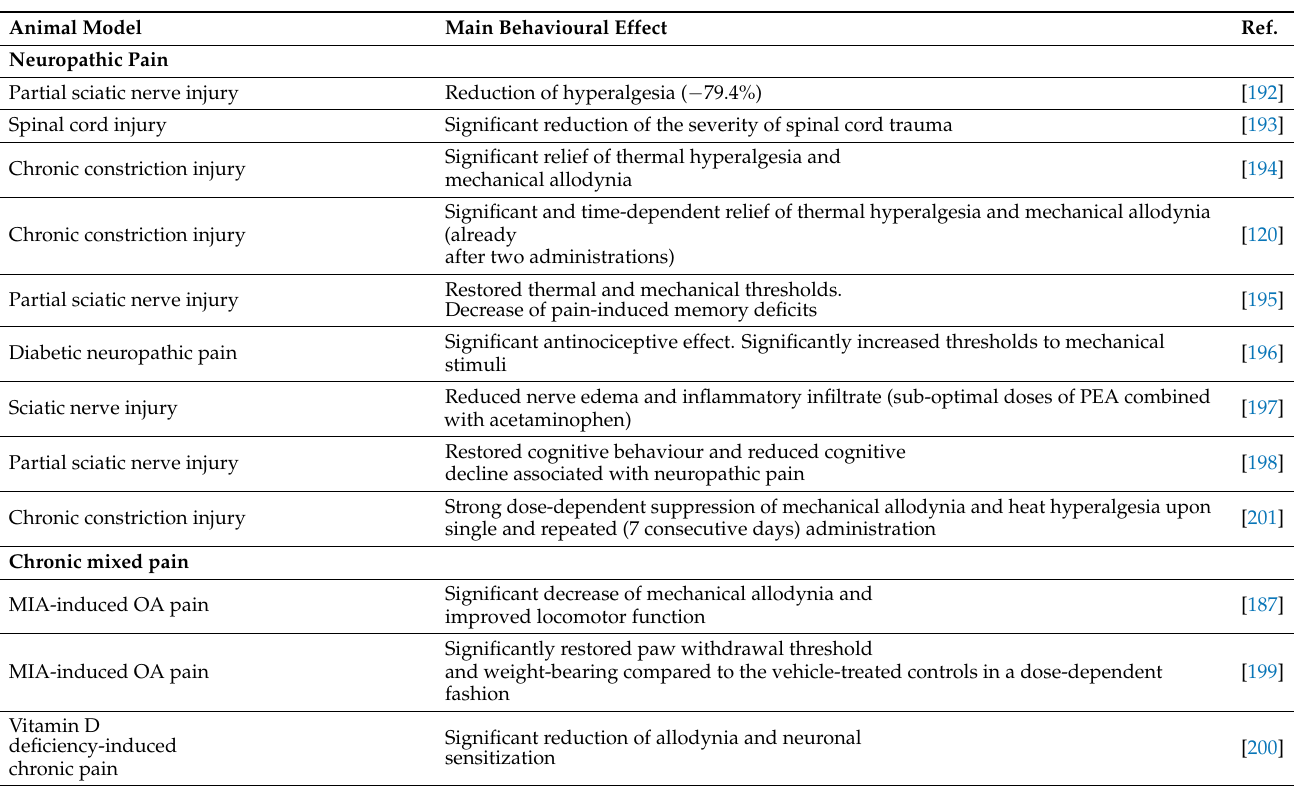
Table 4. Pain relieving effect of PEA—mainly given via intraperitoneal route—in animal models of neuropathic and mixed pain. Summary of studies in chronological